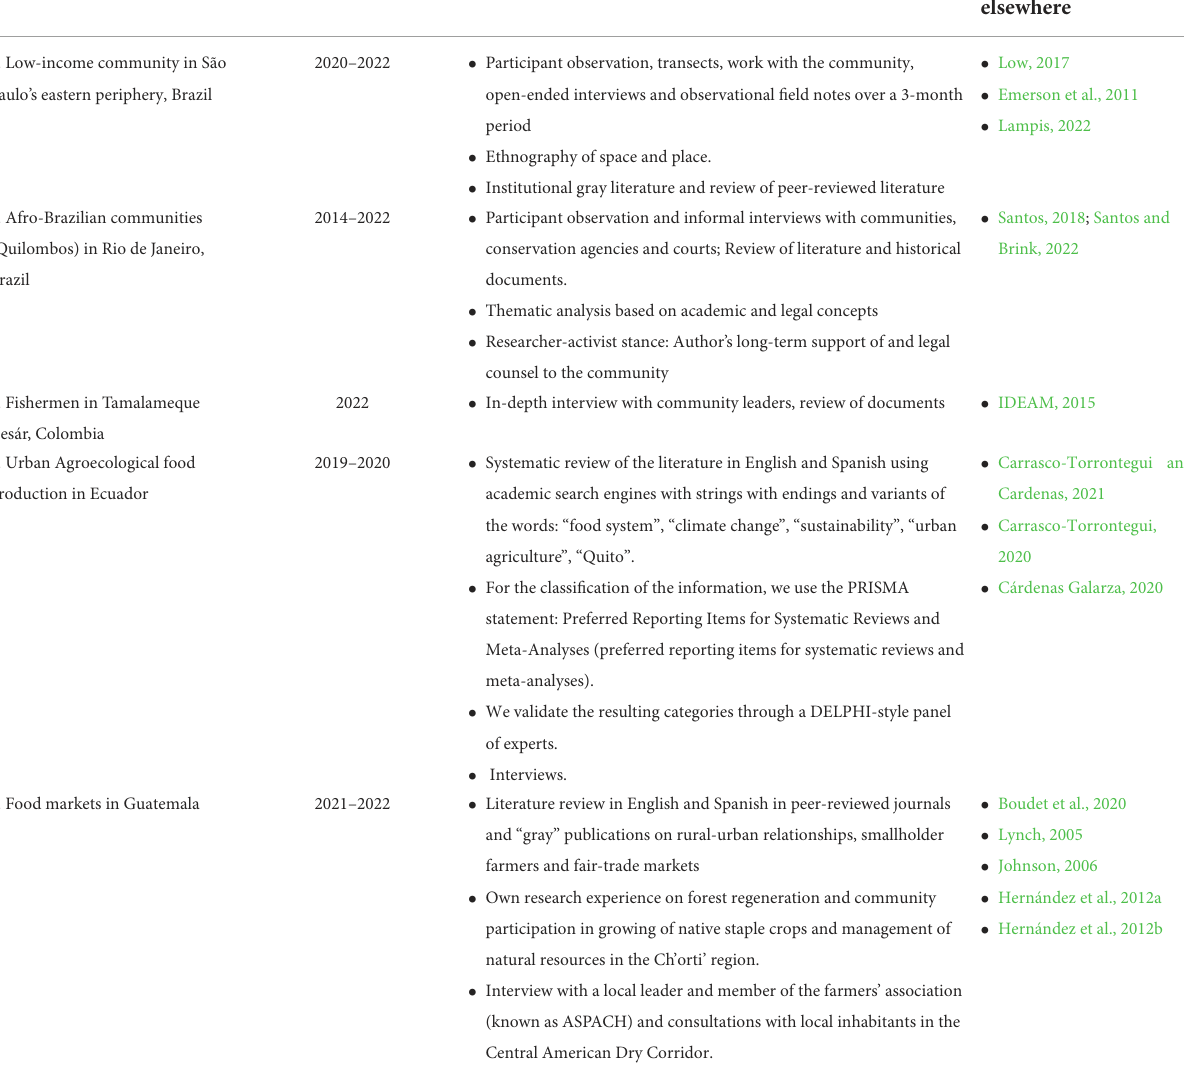
TABLE 1 Overview of the methodological approach for the case